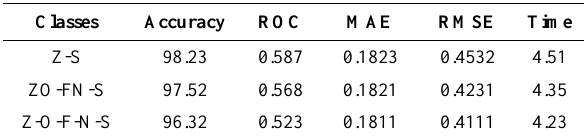
Table 2. Measurement values of the proposed method of three classes